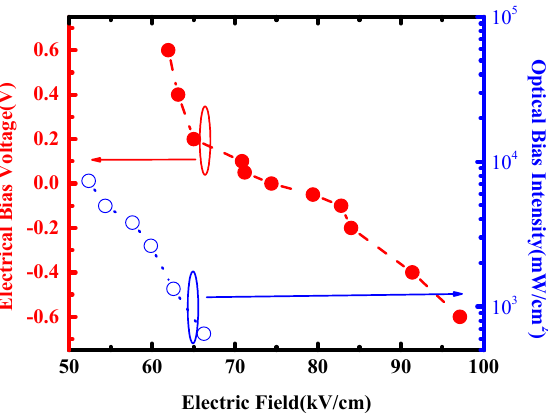
Figure 9. (Color online) Comparison of the change in the GaAs p-n junction’s electric field due to electrical (solid circles) and optical (open circles) biases.